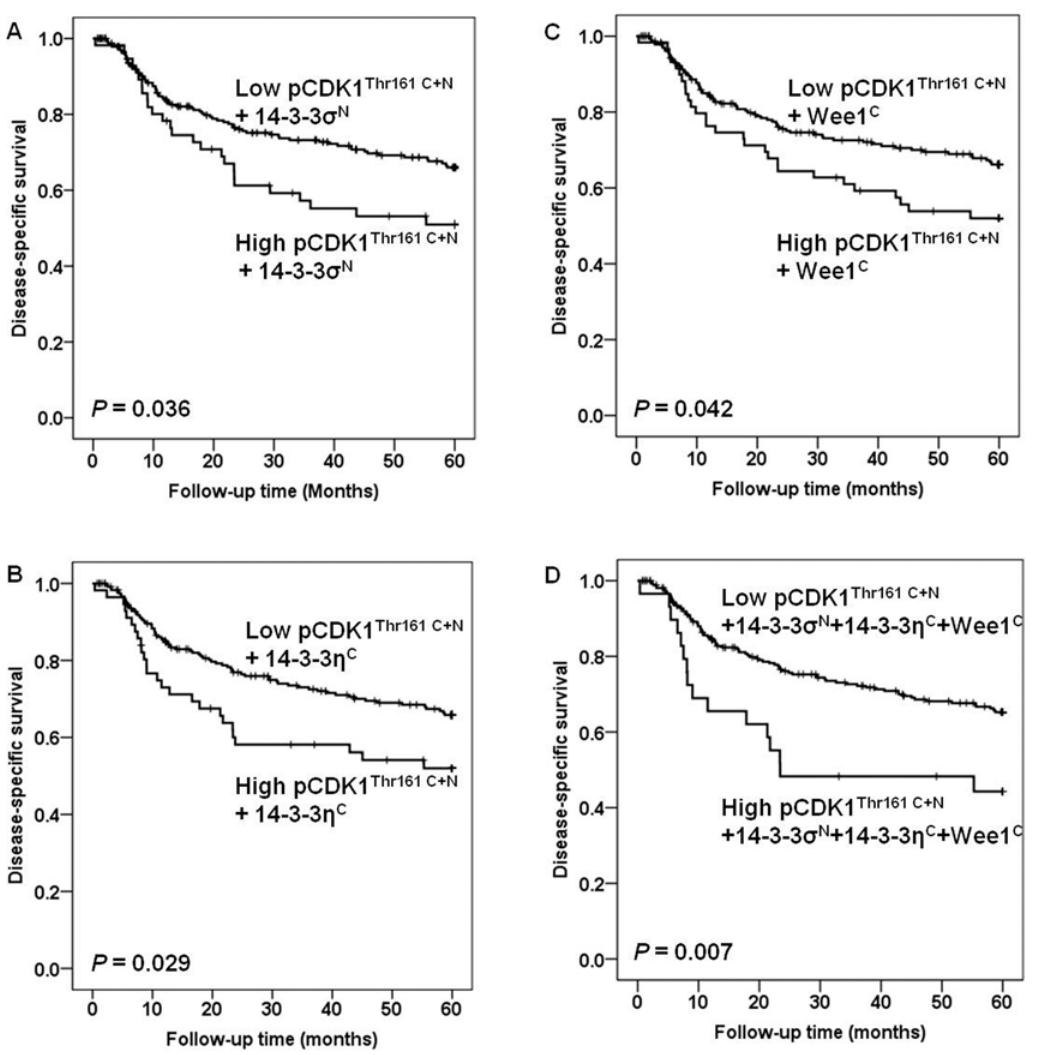
Fig 2. Survival curves using the Kaplan-Meier method (all 297 VSCC included). The Kaplan-Meier curves of disease-specific survival in relation to combinations of (A) (pCDK1 Thr161 C+N + 14-3-3 σ N ), (B) (pCDK1 Thr161 C+N + 14-3-3 η C ), (C) (pCDK1 Thr161 C+N + Wee1 C ) and (D) (pCDK1 Thr161 C+N + 14-3-3 σ N + 14-3-3 η C + Wee1 C ). The p -values differ slightly from those in Table 1 due to the use of the log-rank test as opposed to the Cox-regression